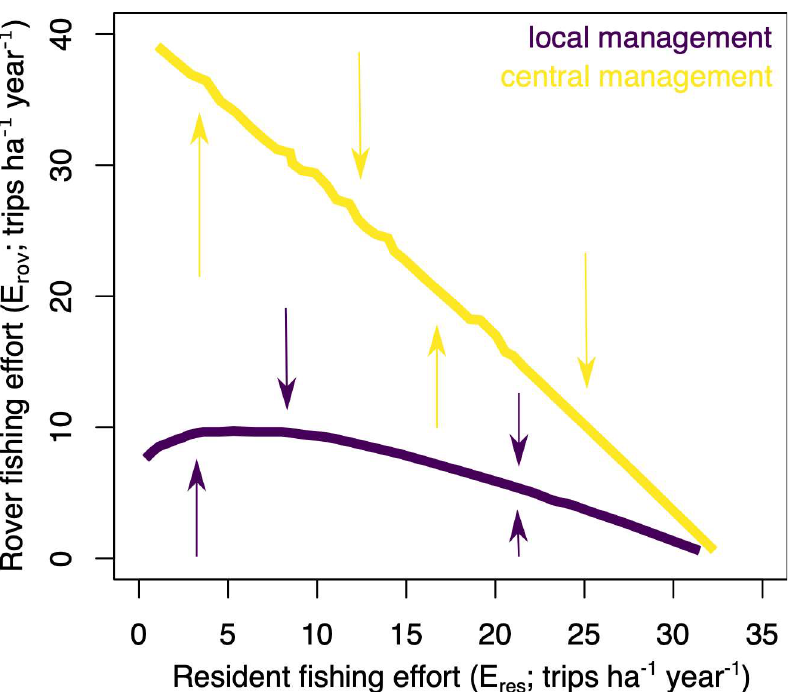
Figure A1.1. Phase plane of equilibrium fishing effort by resident and roving anglers, under local and centralized management. High initial fishing effort from either angler group confers an advantage for equilibrium fishing effort of that group because it reduces catch benefits for the alternative angler group, attracting less of their